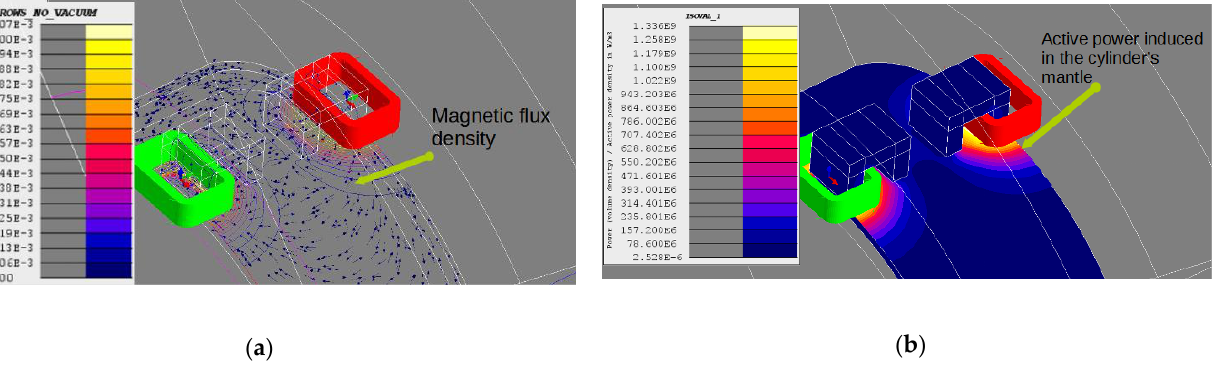
Figure 8. Flowchart of the process of calculating the induction heating of a rotating steel cylinder. In the initial step of the simulation, for time T = 0 and angle α = 0, the distribution of the electromagnetic field in the inductor-cylinder system and the distribution of the active power induced in the cylinder mantle are calculated. These calculations take into account the nonlinear dependence of the magnetic induction B on the electromagnetic field inten- sity H (changing the µ r value). This requires multiple iterations of calculations of the in- duction distribution, B, and of the volumetric active power p v (block [1] in Figure 8), until the convergence conditions are fulfilled. Examples of the results are shown in Figure 9a,b.